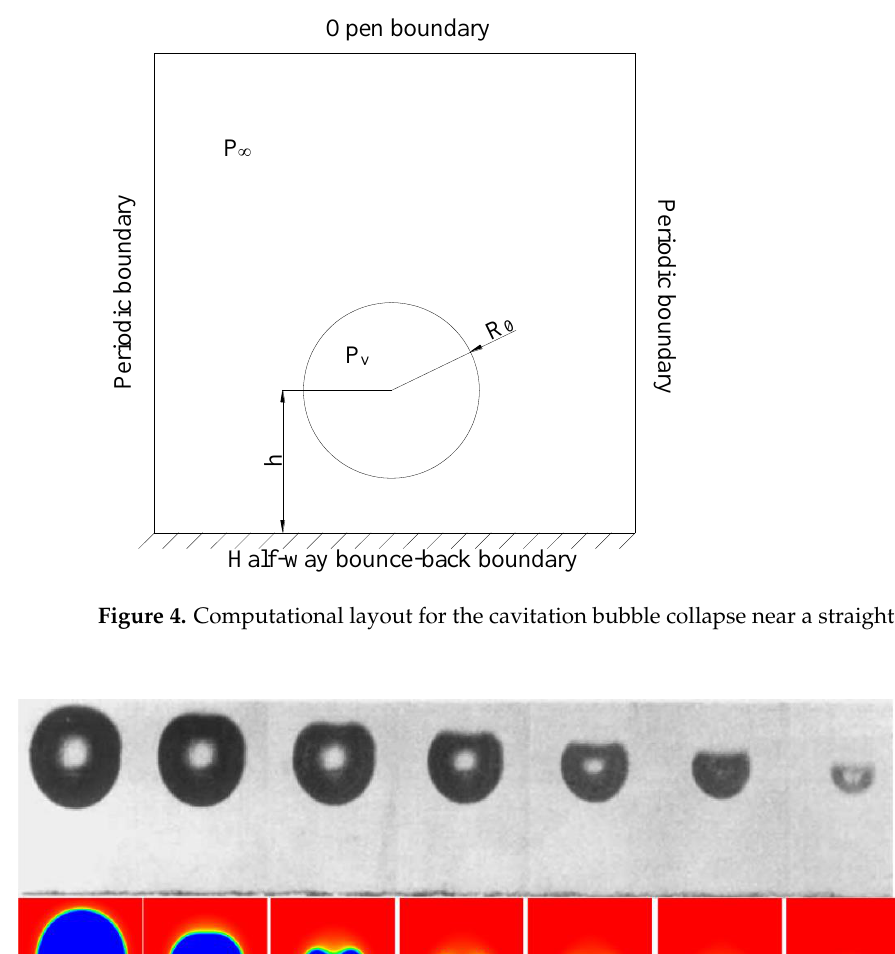
Figure 4. Computational layout for the cavitation bubble collapse near a straight wall.